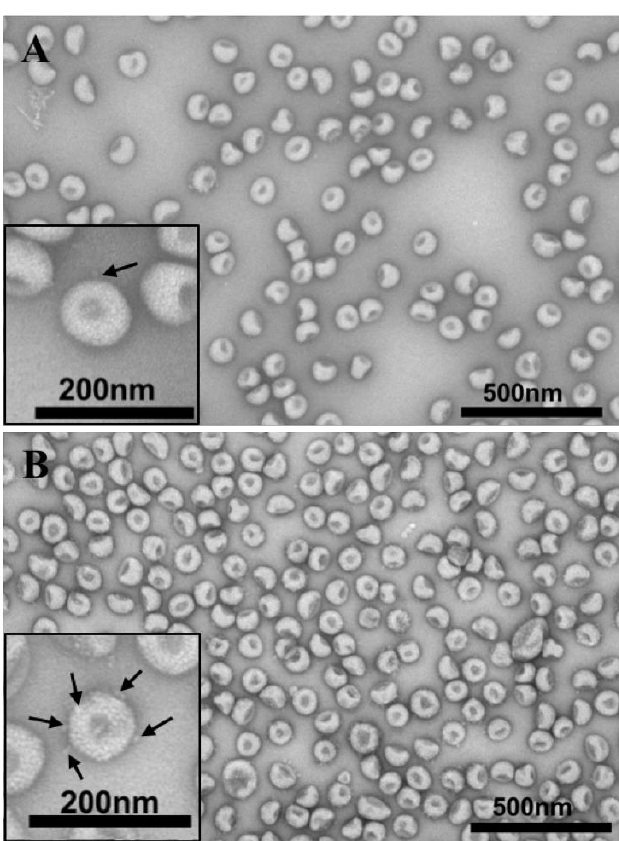
Figure 2. Transmission electron microscopy of CASV-0071 and NDiV-179853. Electron micrograph of potassium tartrate gradient-purified CASV ( A ) and NDiV ( B ) virions following staining with 1% uranyl acetate. Spike protrusions marked with arrows. Scale bar indicated.